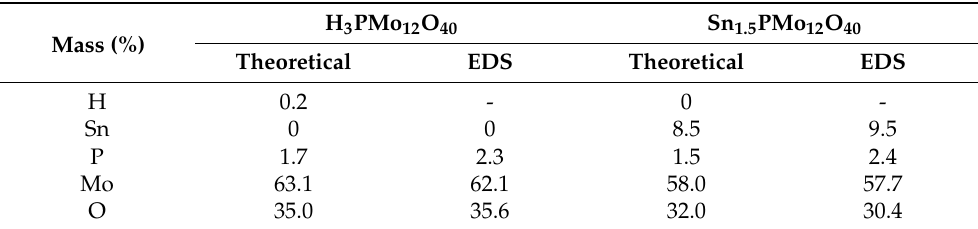
Table 1. Energy dispersive spectroscopy analysis of Sn 1.5 PMo 12 O 40 catalyst and its precursor H 3 PMo 12 O 40 *.